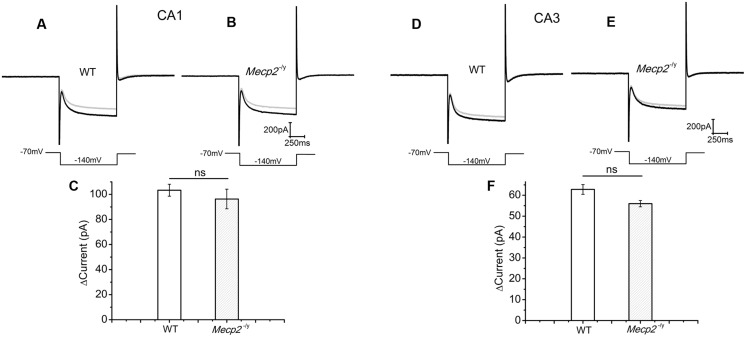
Forskolin induced enhancement of Ih was similar in CA1 and CA3 neurons from both genotypes. Ih was evoked by a step hyperpolarization from a holding potential of -70 to -140 mV for 1 s as shown below each trace. (A) Representative Ih traces from WT CA1 neurons, (n = 4) before (gray) and after (black) forskolin application. (B) Representative Ih traces from Mecp2-/y CA1 neurons (n = 4), before (gray) and after (black) forskolin application. (C) Averaged current amplitude increase by forskolin in CA1 neurons. (D) Representative Ih traces from WT CA3 neurons (n = 4), before (gray) and after (black) forskolin application. (E) Representative Ih traces from Mecp2-/y CA3 neurons (n = 4), before (gray) and after (black) forskolin application. (F) Averaged current amplitude increase by forskolin in CA3 neurons.